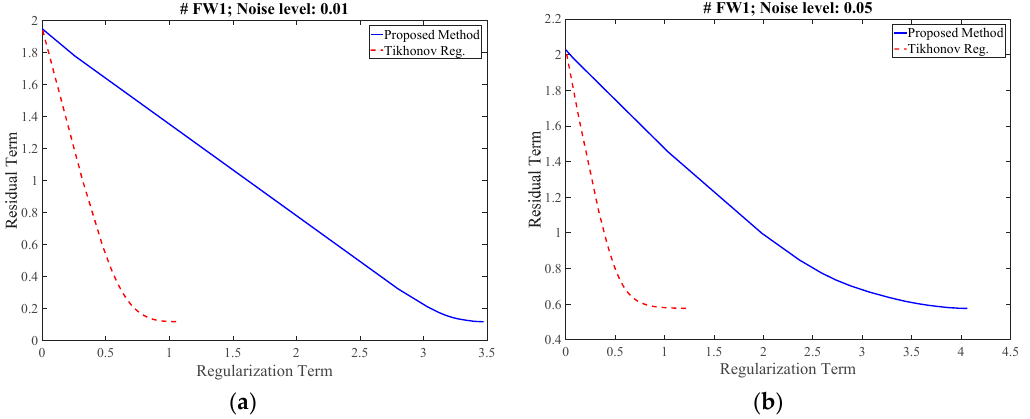
Figure 7. The L-curve plots related to the proposed and Tikhonov regularization approaches for the same waveform at two different noise levels: ( a ) σ =0.01 and ( b ) σ =0.05.